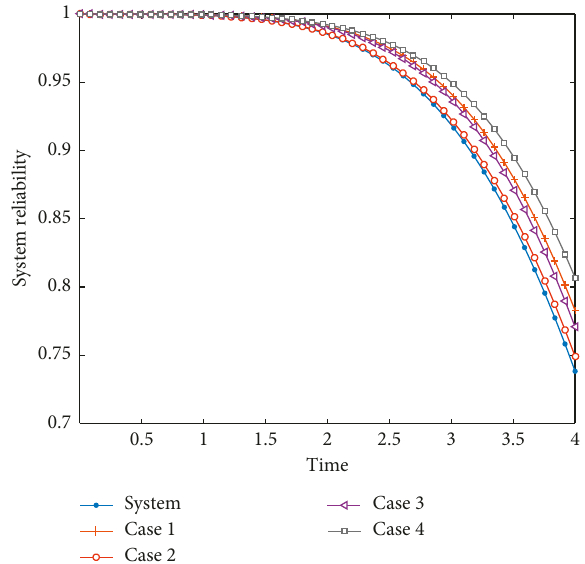
Figure 4: Reliability curves of the system under four different component-swapping cases.